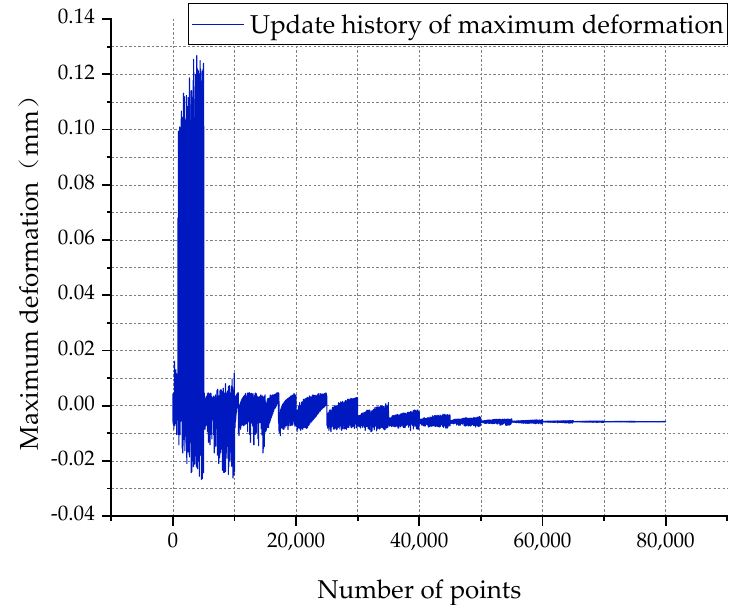
Figure 25. The iterative process of weight.